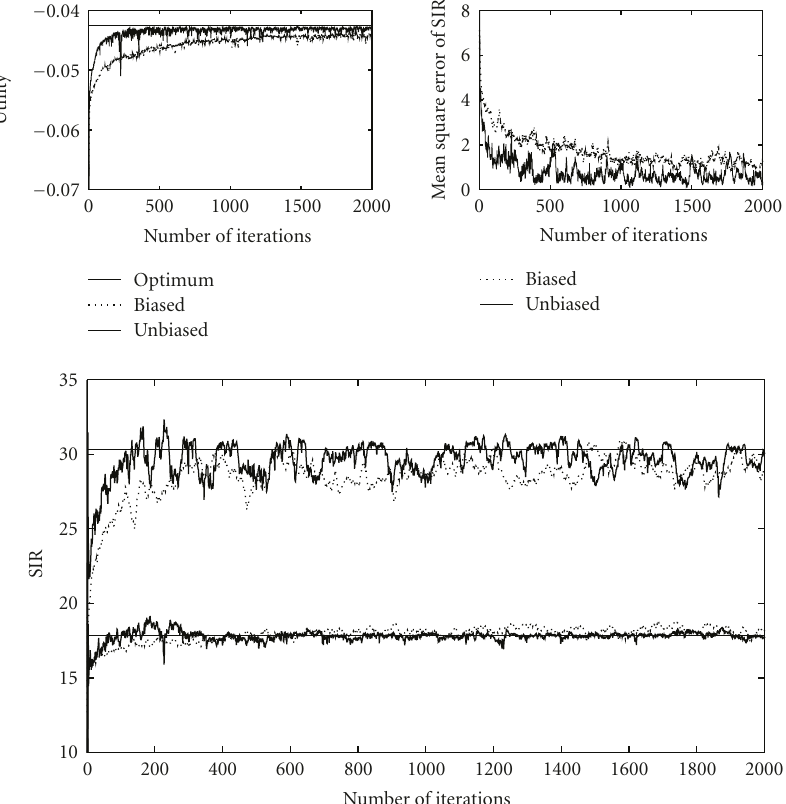
Figure 3: Convergence behavior of the distributed algorithm in case of noisy measurements y = 0 . 4, c 1 = 40, c 2 = 1 for the biased and unbiased